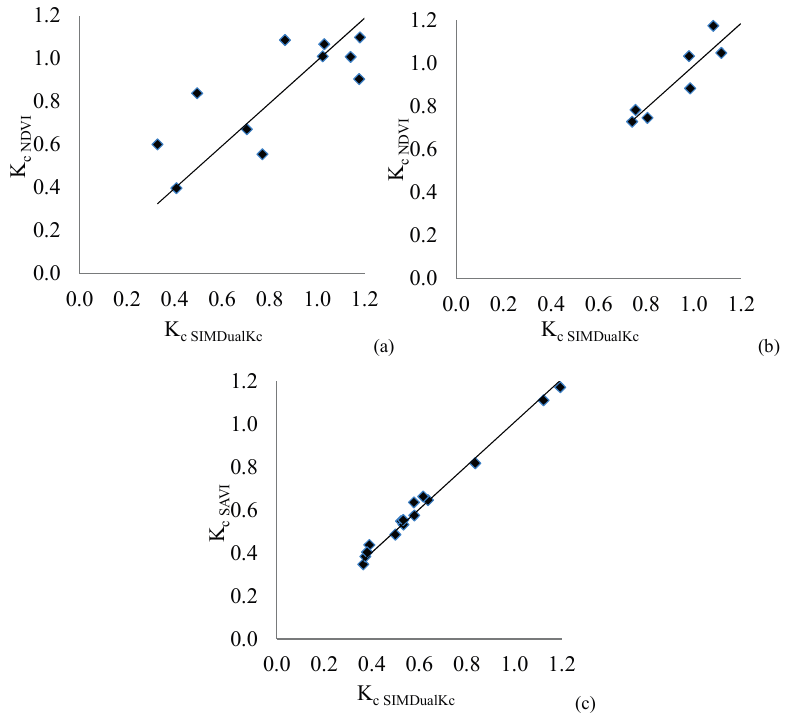
Figure 7. Comparison of actual K c derived from SIMDualKc (K c SIMDualKc ) and actual K c derived from the combined approach of K cb VI and K e from SIMDualKc (K c VI ) for ( a ) maize; ( b ) barley; and ( c ) olive.